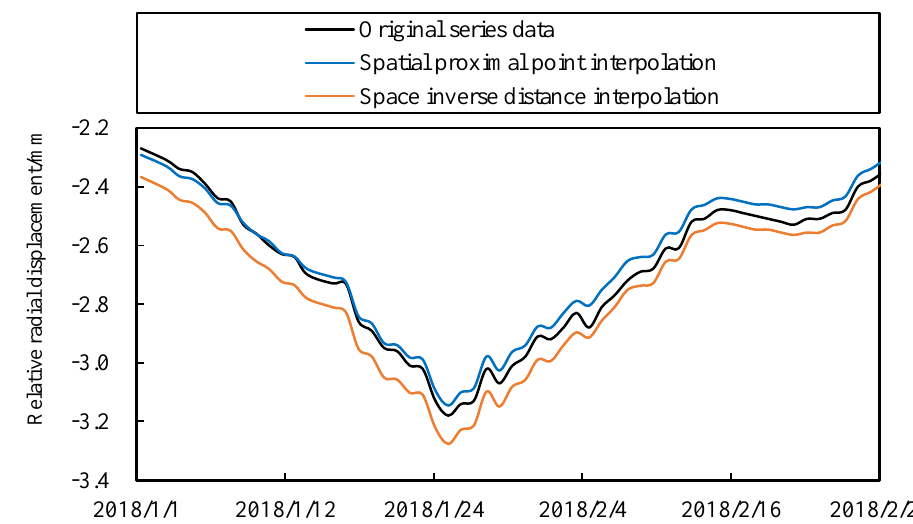
Table 5. Accuracy of the two estimation methods.